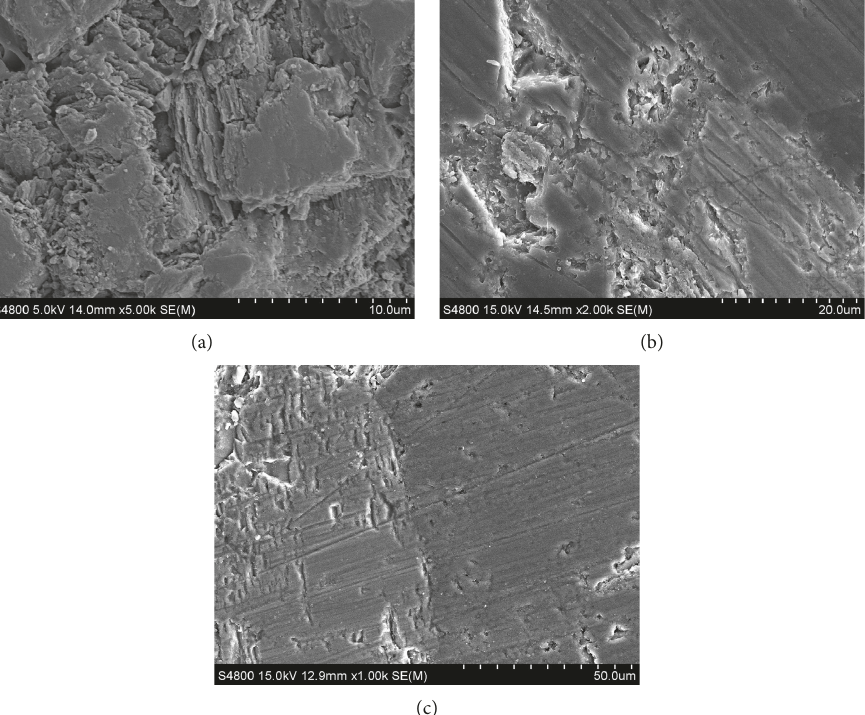
Figure 10: Micromorphology of the basalt surface: (a) before the polishing process; (b) after 20 × 10 4 polishing cycles; (c) after 28 × 10 4 polishing